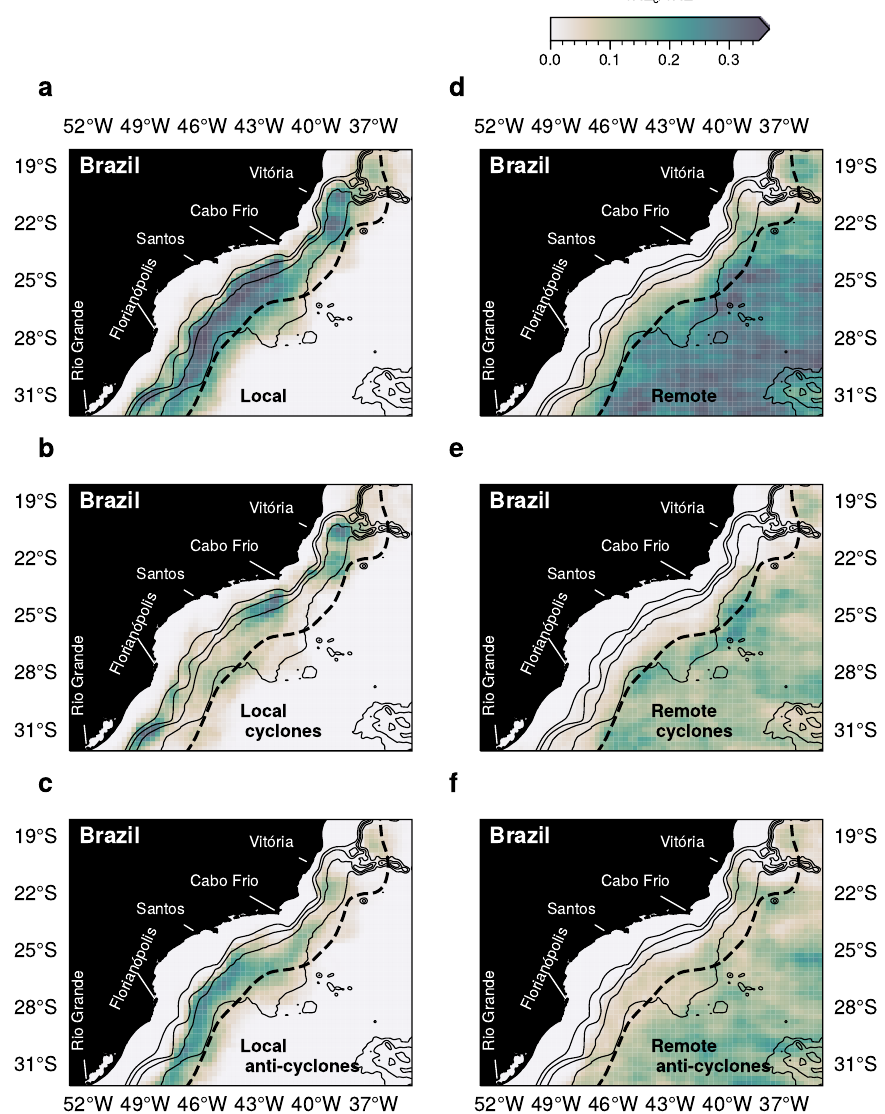
Figure 5. ( a ) Fraction of kinetic energy accounted for by compact, closed-contour eddies generated locally in the Brazil Current region, defined as eddies first identified west of the dashed red line, and its breakdown into the kinetic energy of ( b ) cyclones and ( c ) anticyclones. ( d – f ) Similar to ( a – c ) but for compact, closed-contour eddies generated remotely. The black dashed line marks a distance of 200km from the Brazil Current front in Figure 4, defining the Brazil Current region. Solid black lines depict the 200, 1000, 2000 and 3000-m